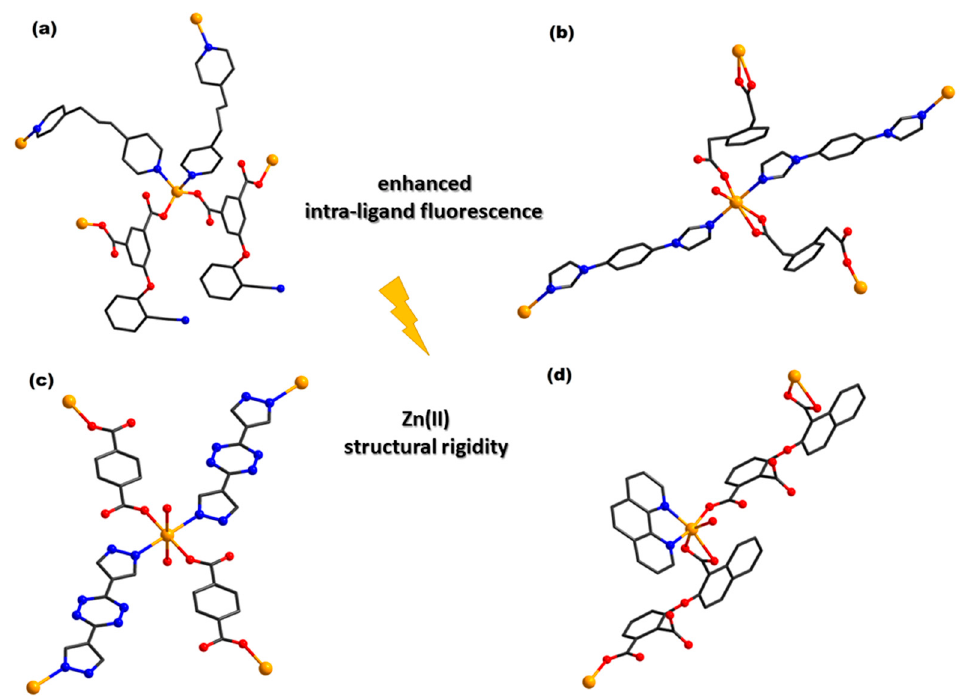
Figure 2. Coordinative site of complexes [Zn(cpif)(bpp)] n ( 32 ) ( a ), [Zn(opda)(pbib)] n ( 43 ) ( b